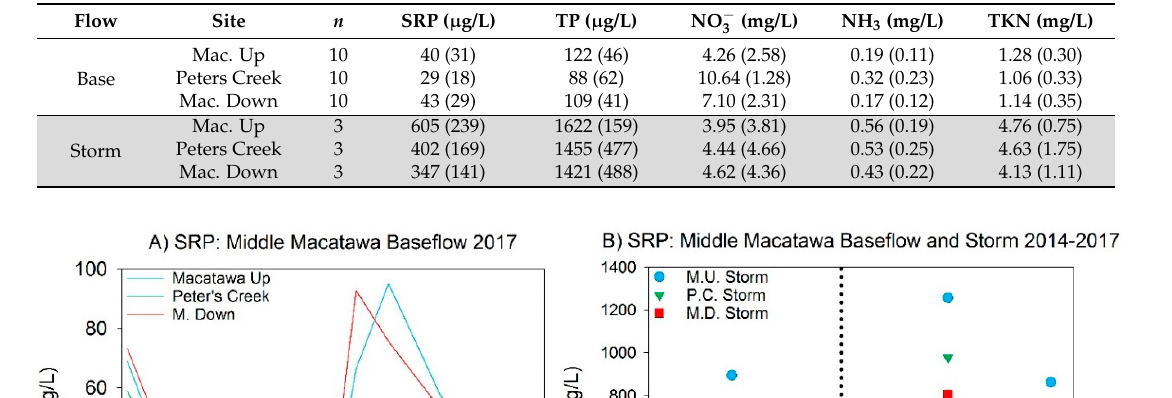
Table 3. Mean (1 SD) values for phosphorus (TP and SRP) and nitrogen (nitrate (NO 3 − ), ammonia (NH 3 ), and total Kjeldahl nitrogen (TKN)) at the Middle Macatawa wetland restoration site from Dec. 2016–Nov. 2017. Storm flow data shown in gray shade.